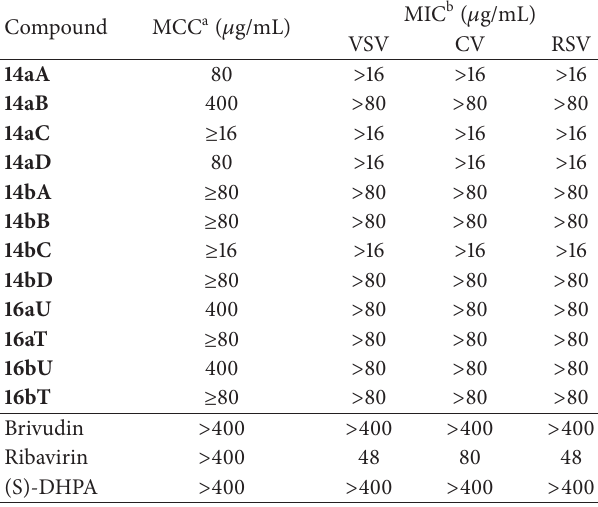
Table 4: Cytotoxicity and antiviral activity of compounds 14a,b and 16a,b in Vero cell